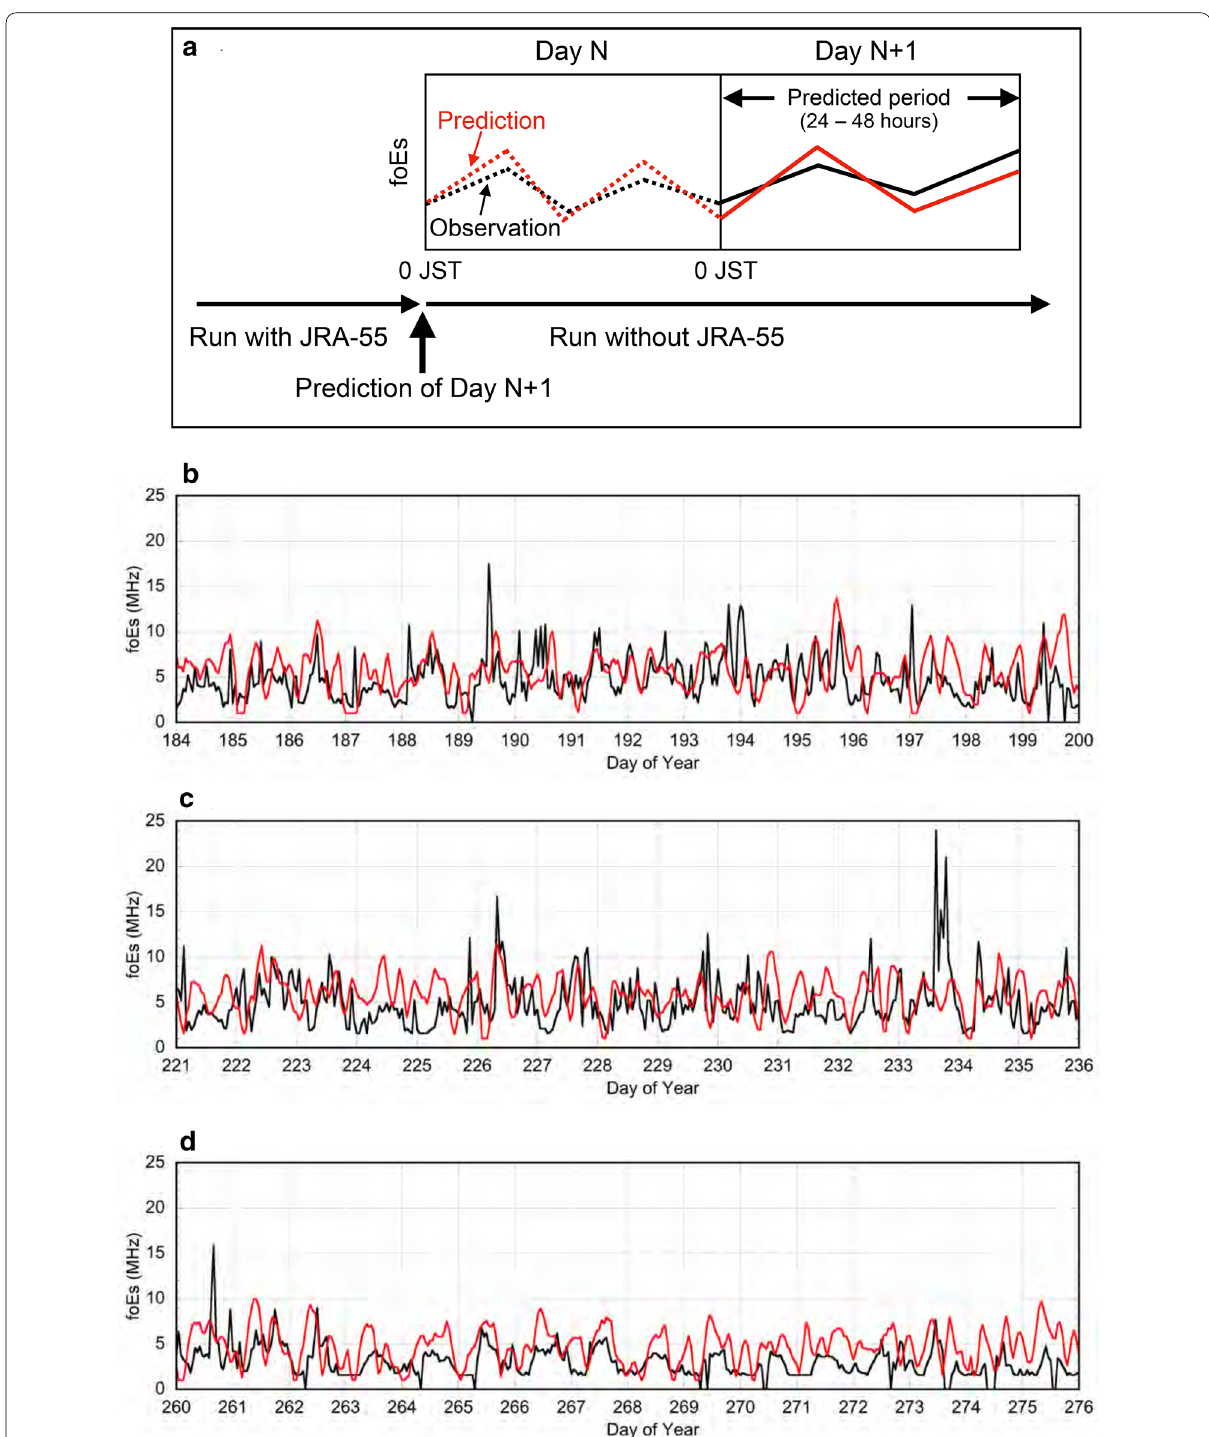
Fig. 12 Comparisons between predicted foEs and observed foEs . a Schematic figure showing the prediction time and the predicted period. Prediction for the 24–48 h later is made at 0 JST. The predicted foEs and the observed foEs for three different periods at Okinawa in late 2019 are compared: b DOY 184–200, c DOY 221–236, and d DOY 260–276. The red line indicates a series of predicted foEs of 24–48 h after the start of “free run” (without JRA-55 data). The black line indicates the observed foEs obtained by the ionosonde at